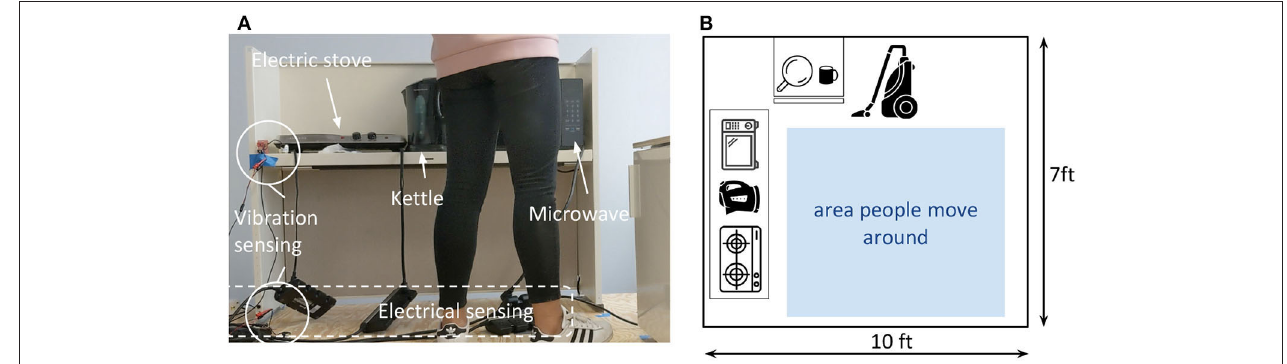
FIGURE 7 | Experimental setup. (A) Side view of the experiment setup, photo. (B) Top view of the experiment